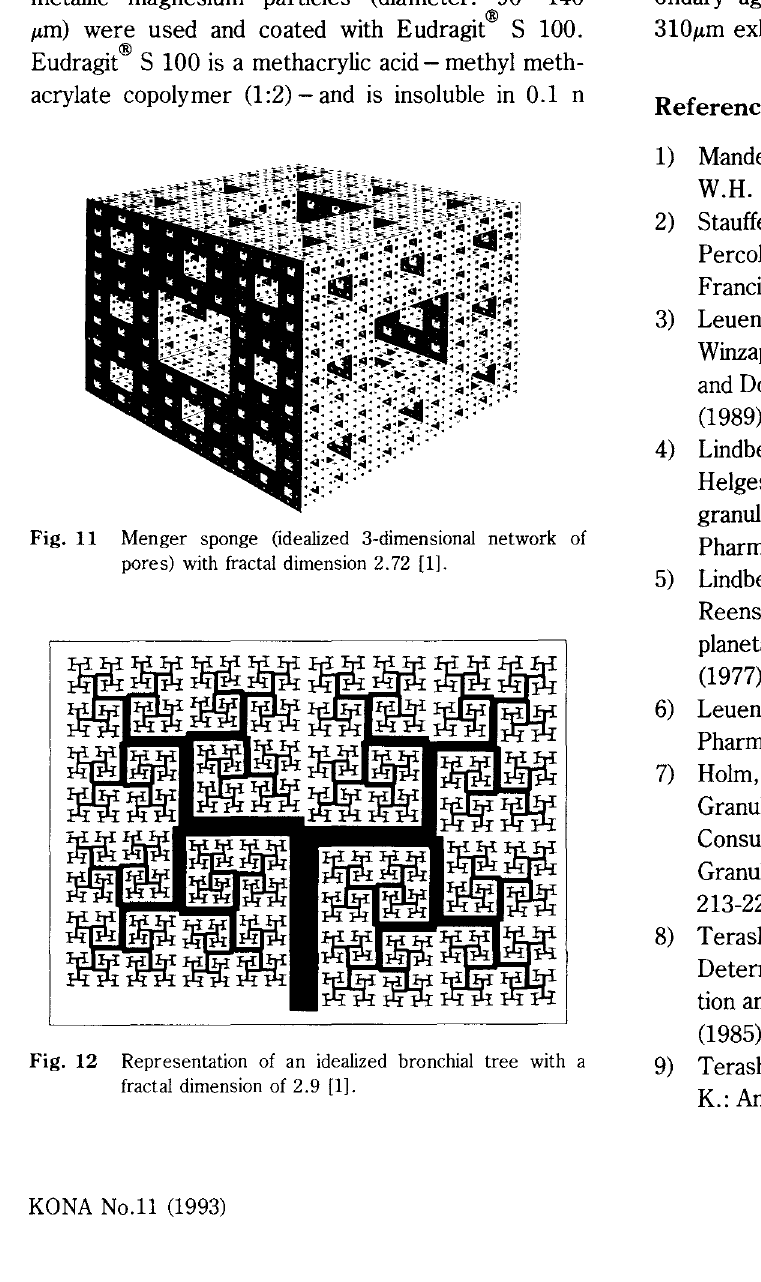
Fig. 11 Menger sponge (idealized 3-dimensional network of pores) with fractal dimension 2.72 [1].